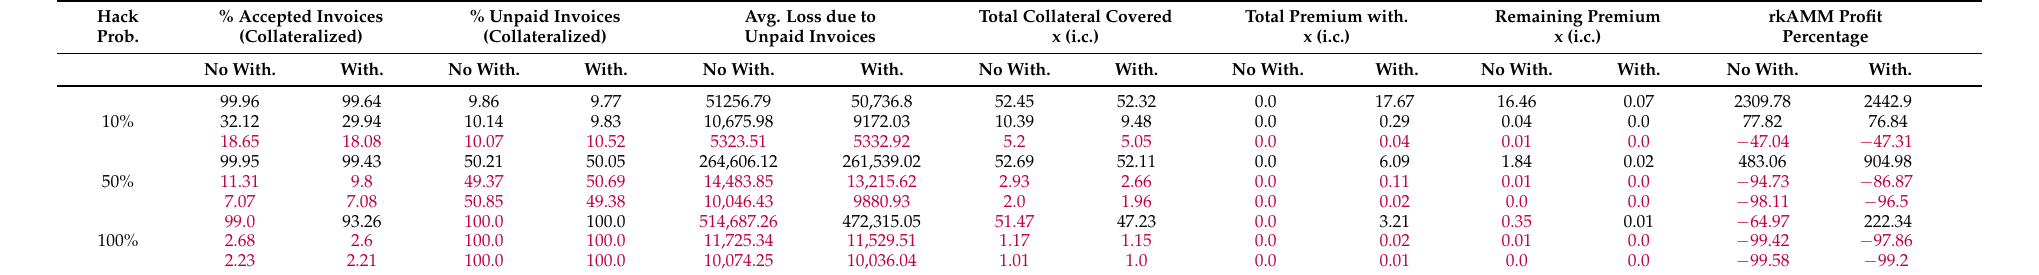
Table 12. rkAMM hack scenario results. Every 30 days, 50% of the premium obtained is